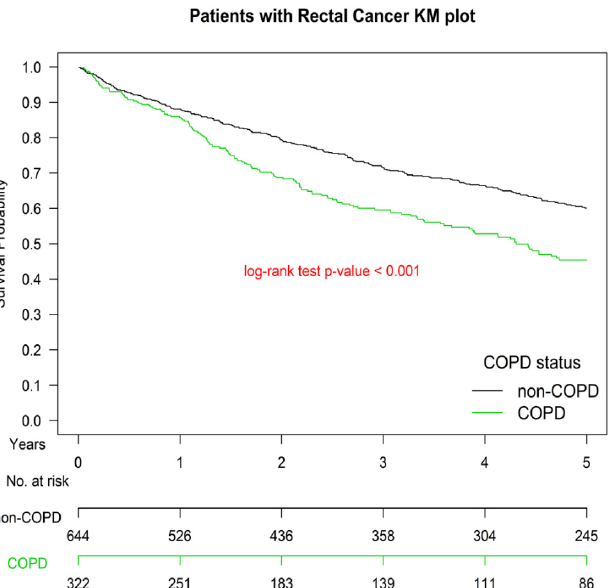
Figure 1. Kaplan–Meier survival curves of patients with rectal adenocarcinoma with or without smoking-related chronic obstructive pulmonary disease before surgery after propensity score matching, COPD, chronic obstruction pulmonary disease.